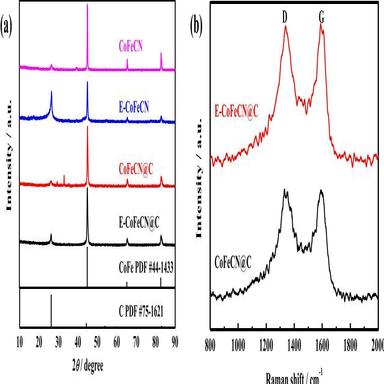
(a) XRD patterns of different samples; (b) Raman patterns of CoFeCN@C and E-CoFeCN@C.